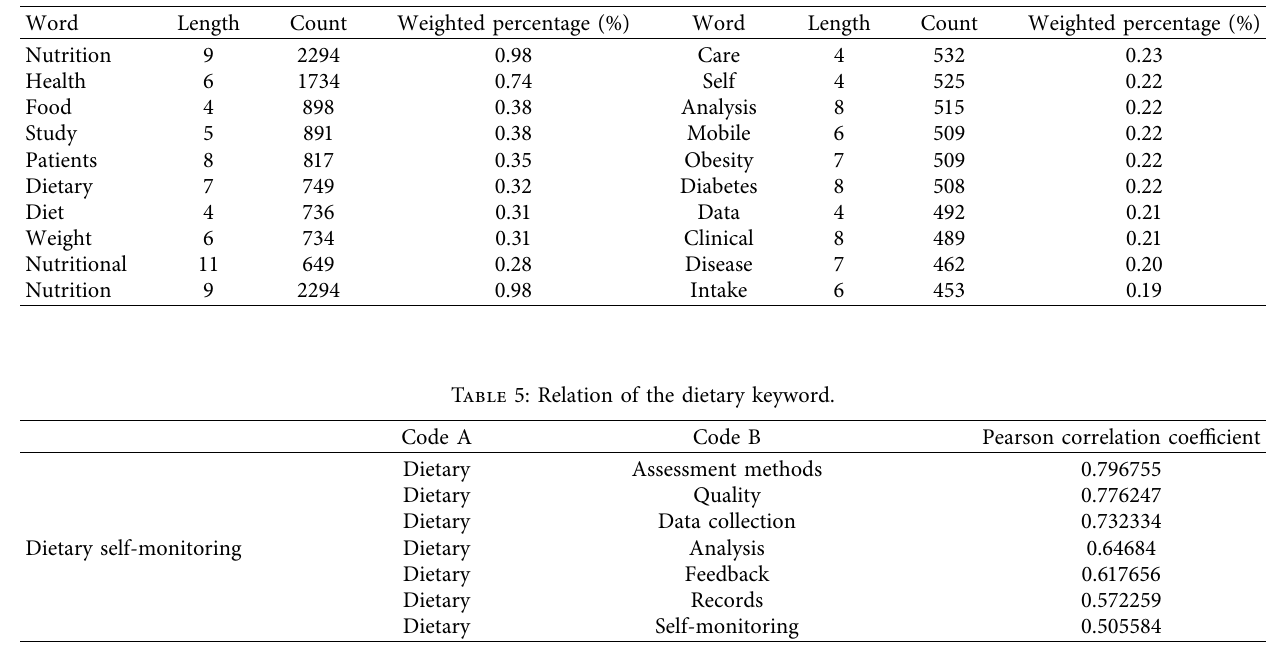
Table 4: Trending topics of keywords.